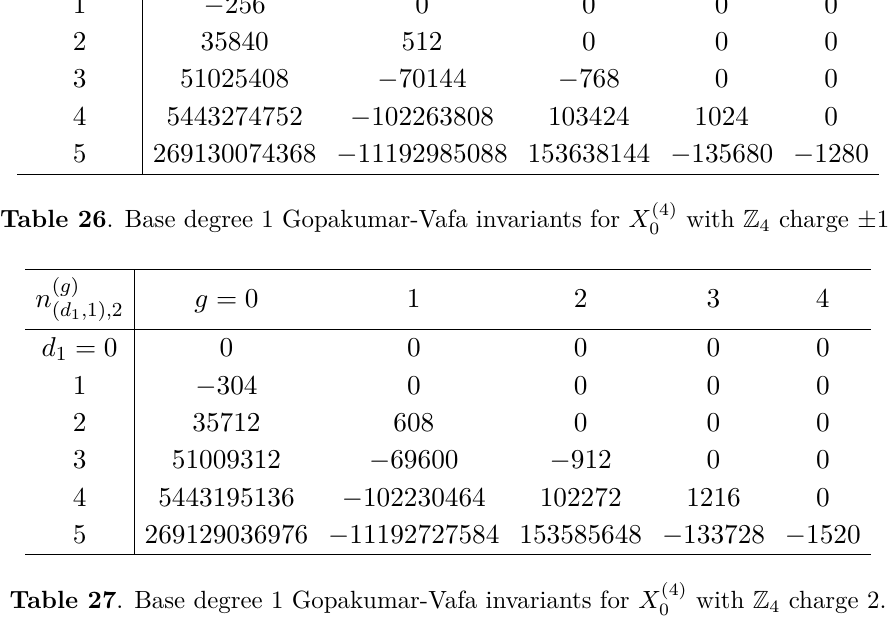
Table 27 . Base degree 1 Gopakumar-Vafa invariants for X (4)